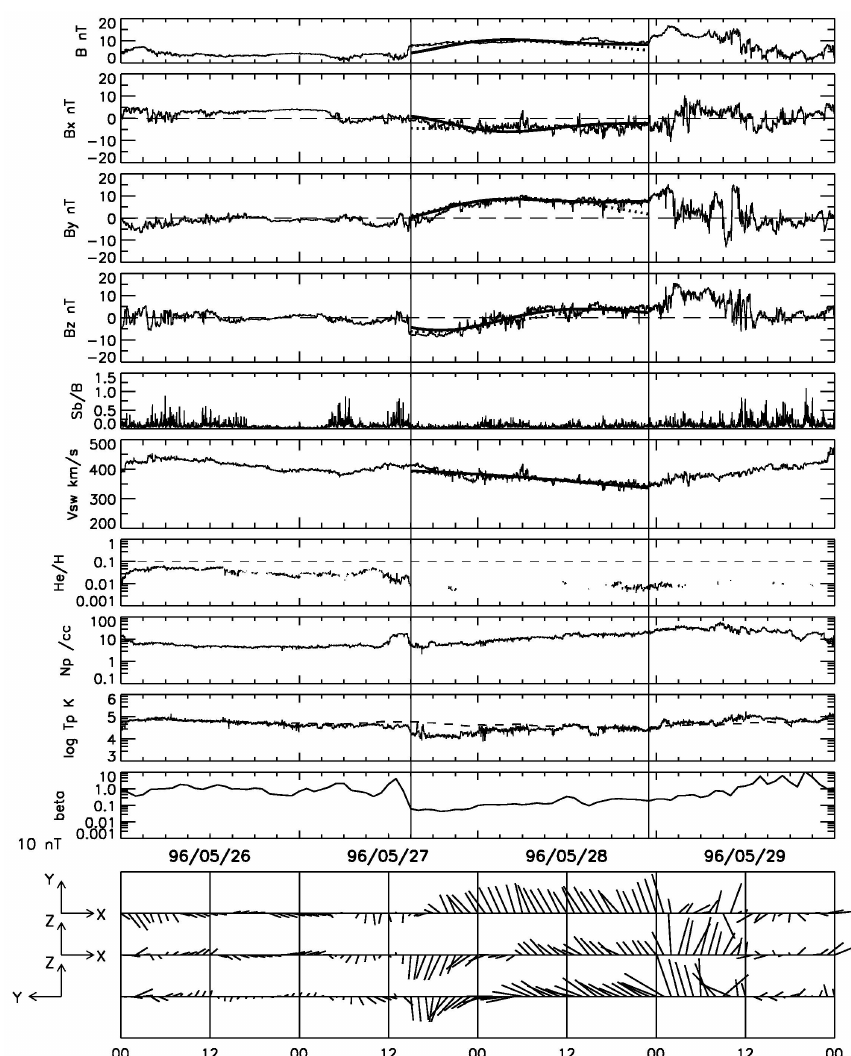
Fig. 10. Results of the fitting with the torus model (solid curve) and with the cylinder model (dotted curve) to the magnetic cloud (MC) encountered on 27 May 1996 (Event No. 2) in the same format as Fig. 4. The bottom three panels show the projected magnetic field vectors.